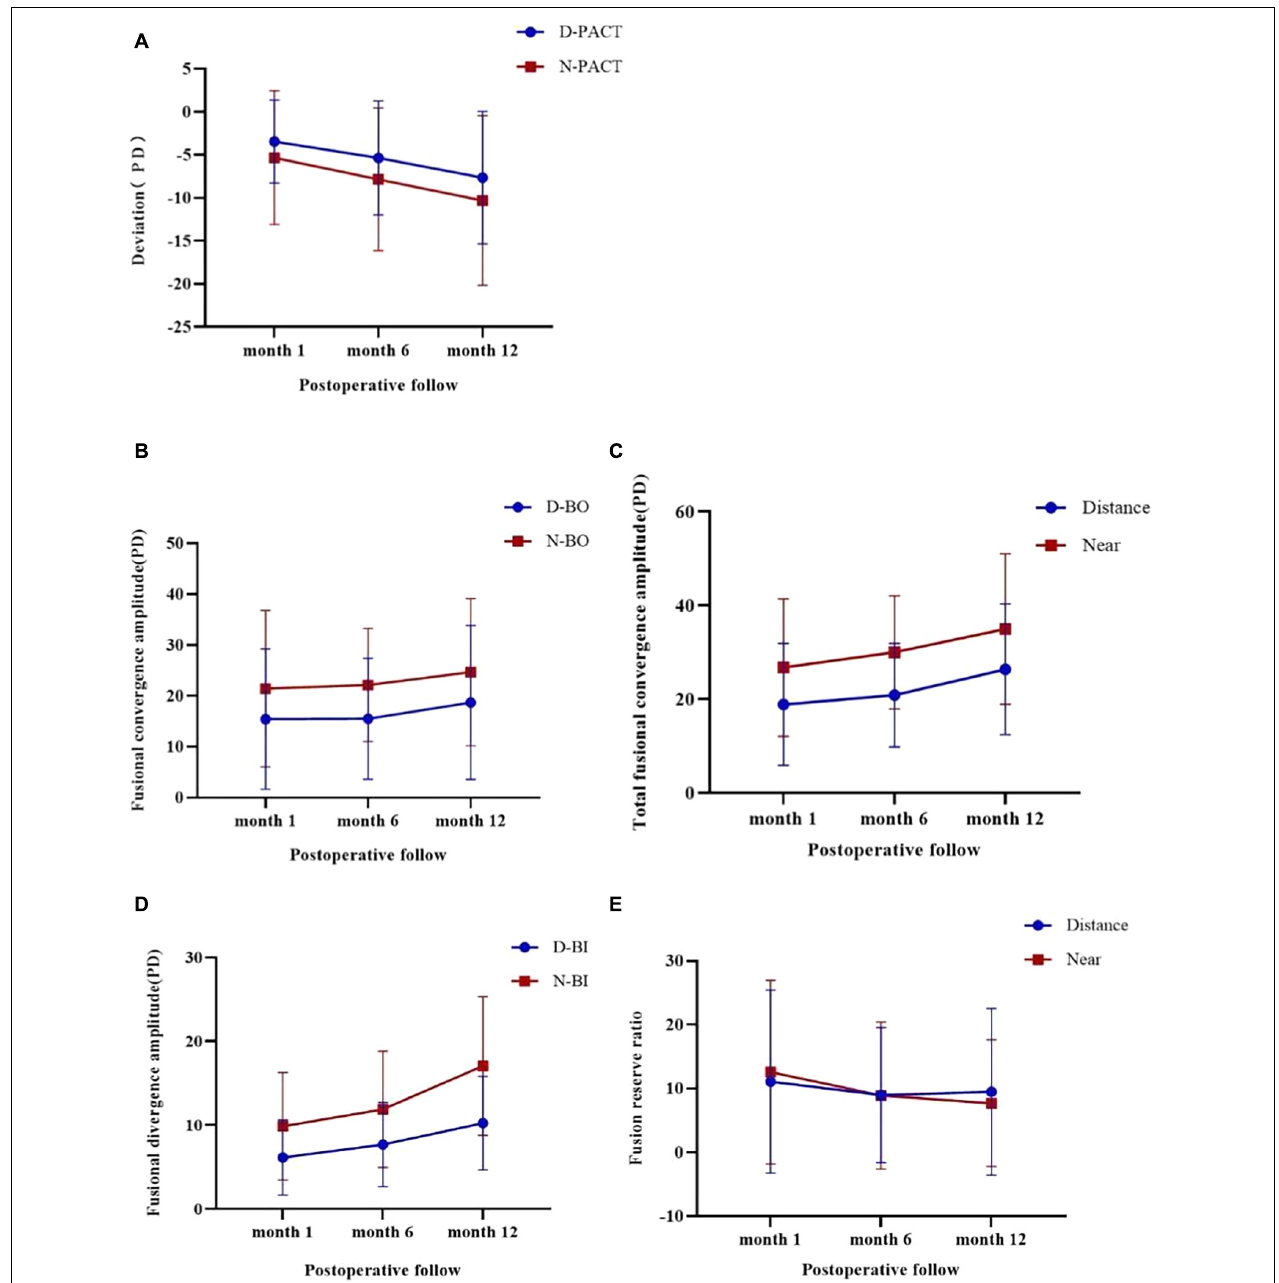
FIGURE 1 | Changes in the eye position and fusional vergence amplitude during the three follow-ups after surgery and using the Friedman test. A negative value indicates an exodrift. (A) Shows that the eye position steadily drifts outwards for distance and near fixations ( p < 0.001). (B) Shows that the BO break point leads to different recoveries in distance and near fixations ( p = 0.045 and p = 0.000, respectively). (C) Shows that the total fusional convergence amplitude has different recoveries in distance and near fixations ( p = 0.169 and p = 0.000, respectively). (D) Shows that the BI break point has different increases in distance and near fixations ( p < 0.001). (E) Shows that the fusion reserve ratio worsens in distance and near fixations ( p = 0.001 and p < 0.001,